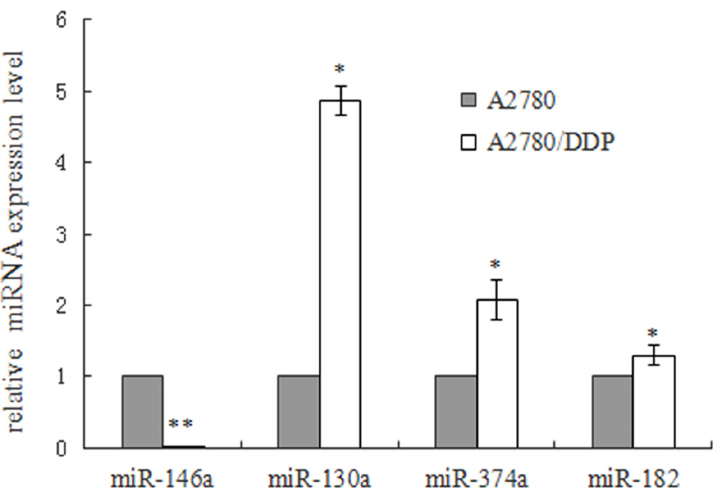
Fig 1. RT-qPCR validation of the selected 4 miRNAs expression in A2780s and A2780/DDP cells. The level of miR-146a in A2780/DDP was extremely low, only accounts for 0.75 percentage of that in A2780s ( ** p < 0.05). The expression of miR-130a, -374a and miR-182 was 4.8, 2.08 and 1.28 folds higher than that in A2780 cells ( ** p < 0.05, * p < 0.05).These results showed the consistent expression changes detected by the microarray.